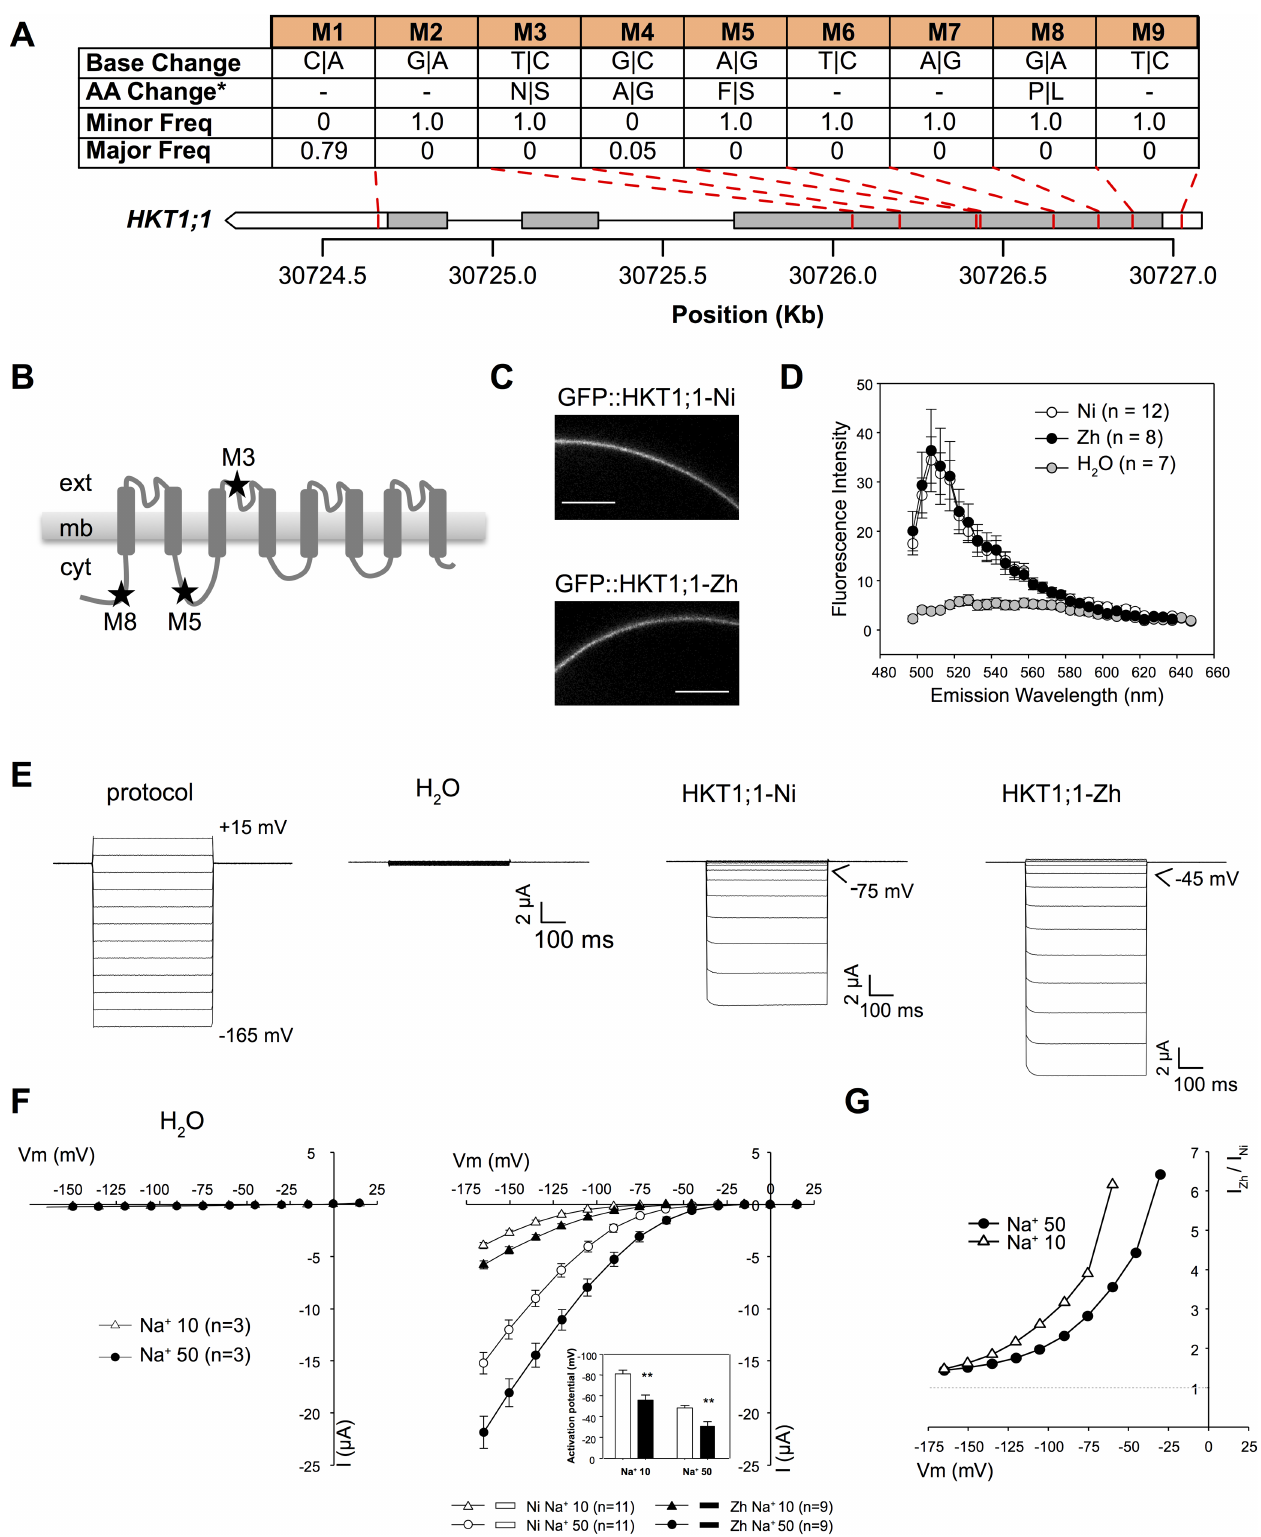
Fig 6. Characterization of high and low root Na + isoforms of HKT1;1 in Xenopus oocytes. (A) Genetic variants within the ORF of HKT1;1 . “Minor Freq” and “Major Freq” indicate the frequency of the alternate allelein the major ( n = 19) and minor ( n = 13) allelicgroupsat SNP-4-